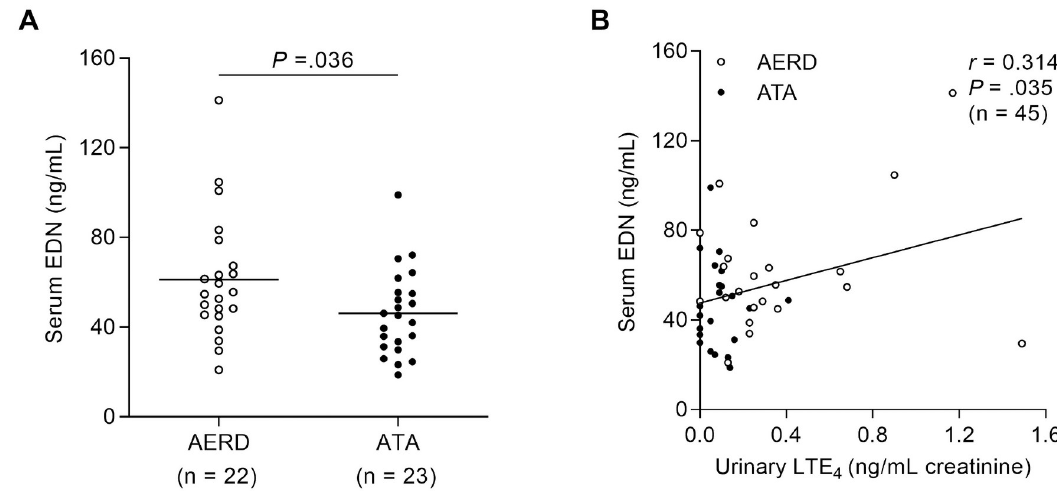
Fig 3. Relation between levels of urinary LTE 4 and serum EDN. (A) Levels of serum EDN in the study subjects. Data are presented as mean. P values were obtained by Student’s t test. (B) A correlation between the levels of serum EDN and urinary LTE 4 . Data are represented as Spearman correlation coefficient r ( P